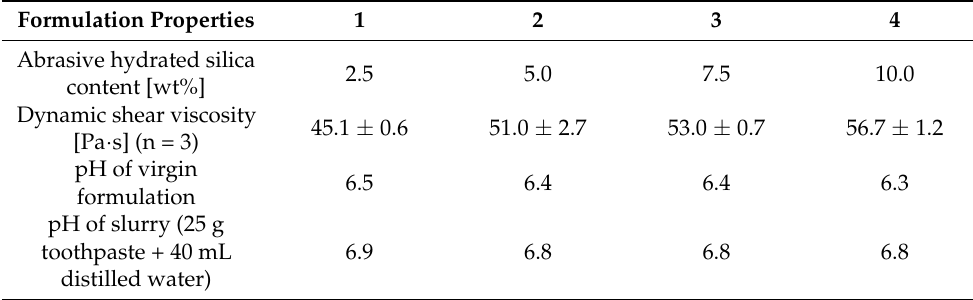
Table 2. Viscosity and pH values for the four model toothpaste